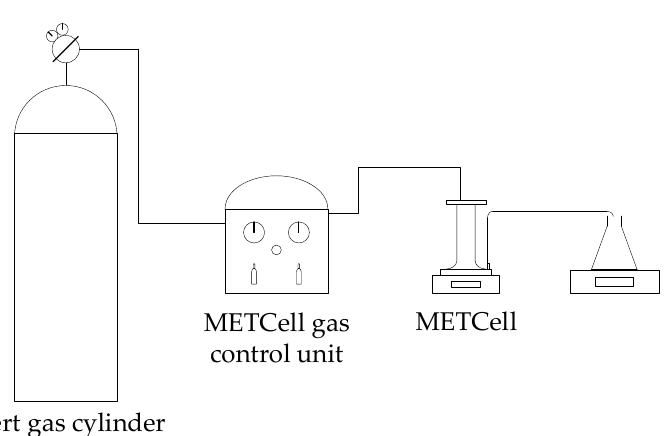
Figure 2. Schematic diagram of the MET ® Cell filtration system.